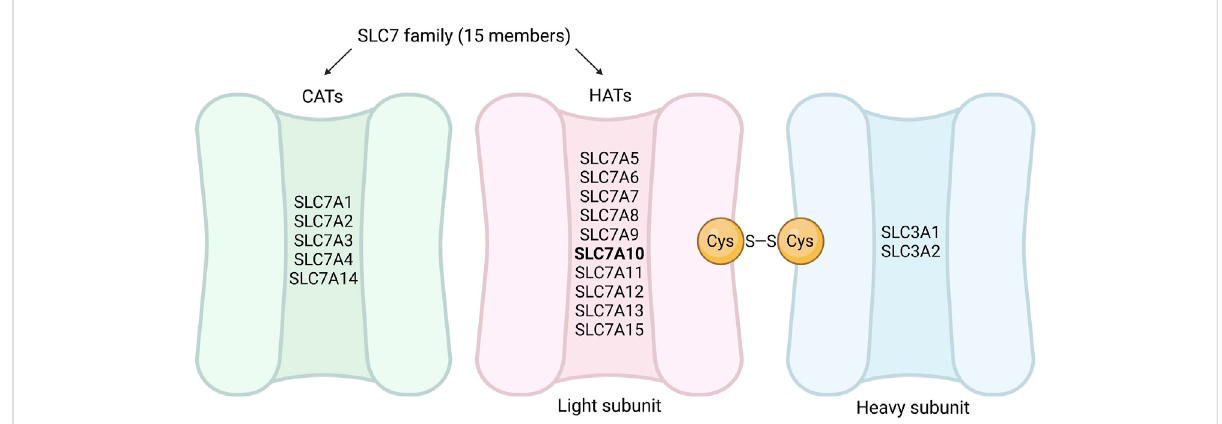
Subclassi fi cation of the SLC7 family into CATs and HATs. The SLC7 family can be divided into two subgroups, CATs (represented in green) and HATs (represented in pink). SLC7A1-4 and SLC7A14 are within the CATs subgroup, and SLC7A5-SLC7A13 and SLC7A15 are the light subunits in the HATs subgroup (SLC7A10 highlighted with bold text). The HATs generally associate with a heavy subunit from the SLC3 family (represented in blue) through a conserved disul fi de bond (cysteine residues represented as yellow circles). The fi gure is simpli fi ed and not representative of the sizes of the CATs and HATs, nor the positioning of the disul fi de bond. CATs, cationic amino acid transporters; HATs, hetero (di) meric amino acid transporters; Cys, cysteine. Figure created in